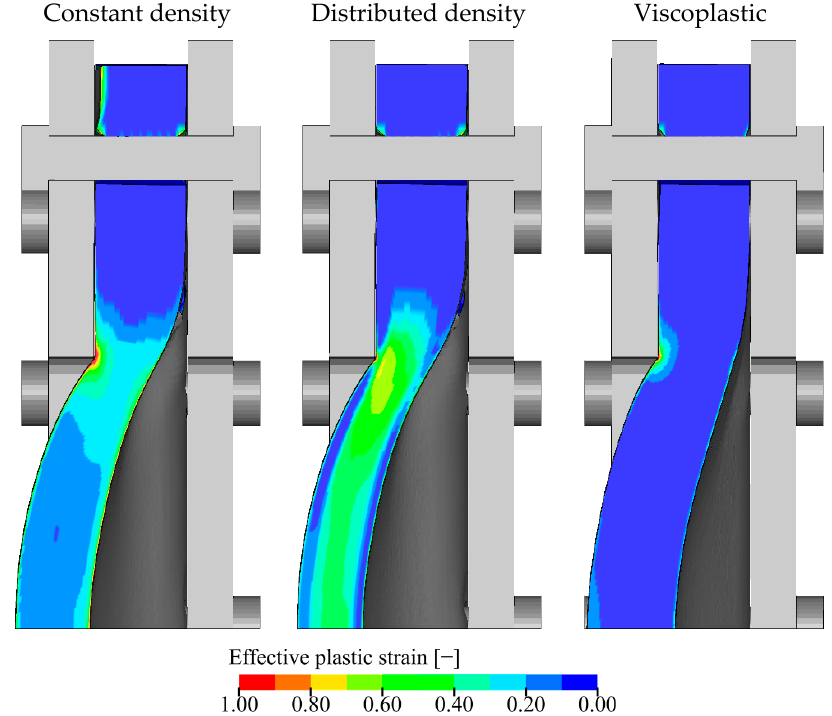
Figure A14. Deformation profiles and plastic strain from numerical simulations of test Sw_400_P15.